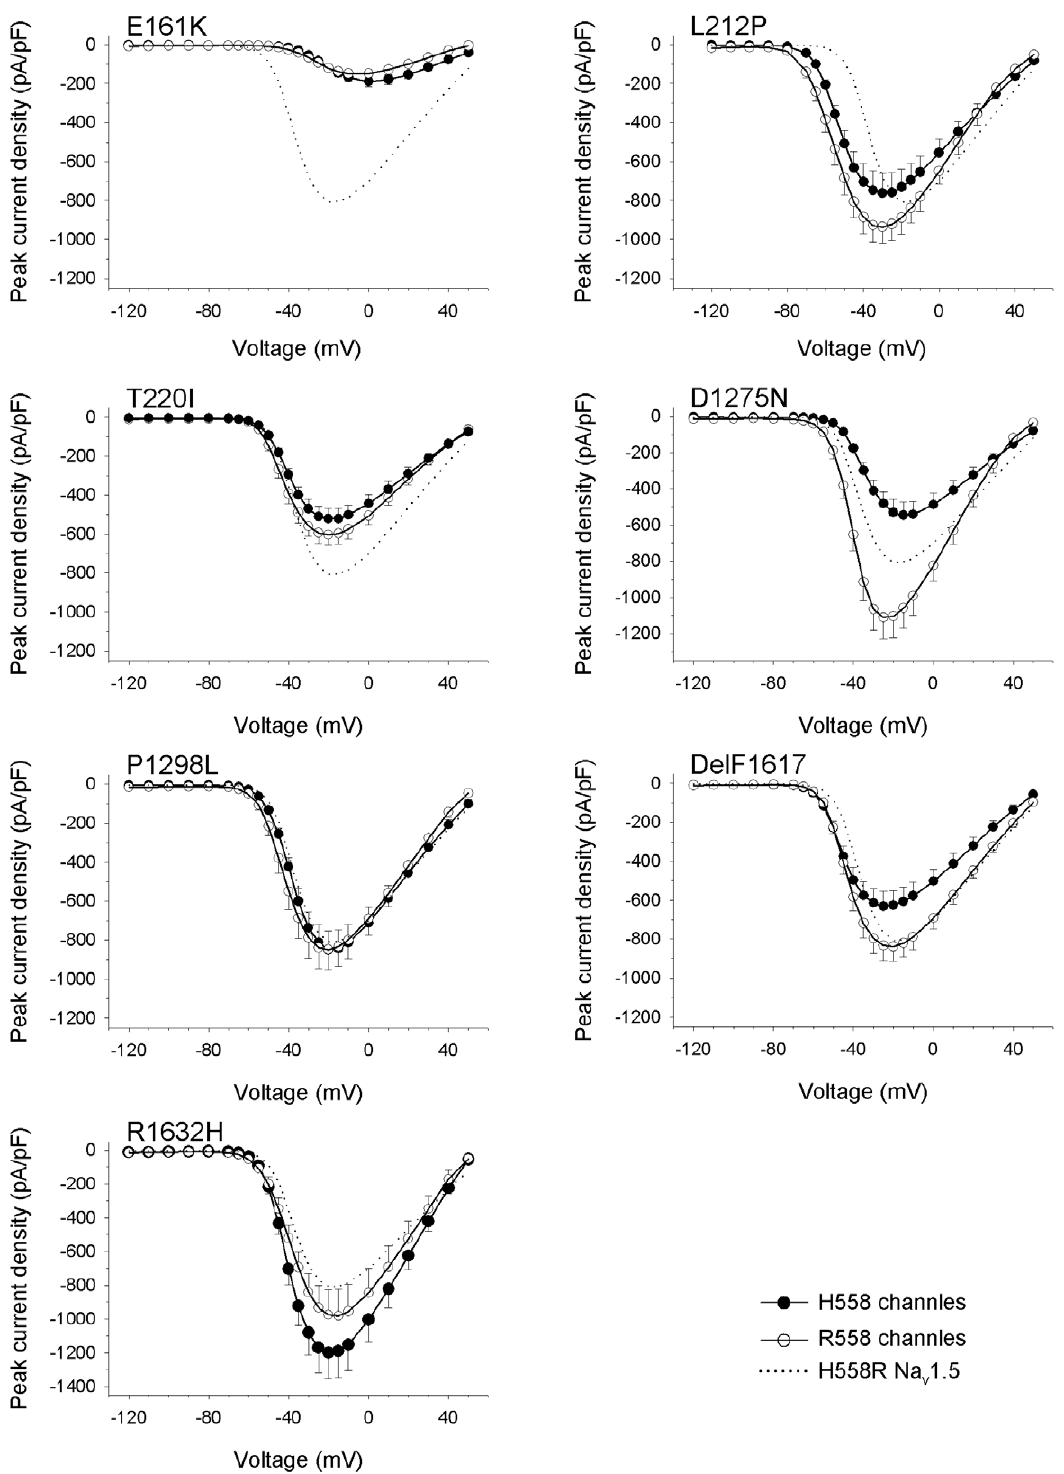
Figure 2. Electrophysiological properties of four group 1 mutant channels expressed by HEK293 cells. Individual parameters are summarized in Table 1. (A) Peak current-to-voltage ( I–V ) relationships. Currents were elicited from the holding potential of 2 120 mV to the test potentials indicated. (B) Steady-state activation as a function of voltage. (C) Steady-state inactivation as a function of voltage. (D) Recovery from inactivation. Normalized data were fitted to double exponentials yielding the fast and slow time constants listed in Table 1. (E, F) Time constant of inactivation ( t h ) as a function of voltage. Parameters were obtained from monoexponential fits. Error bars represent the mean 6 SEM.